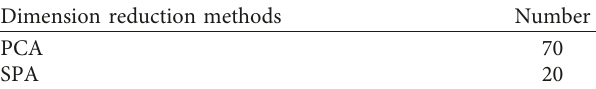
Table 7: The best number of the neurons in the hidden layer of ELM